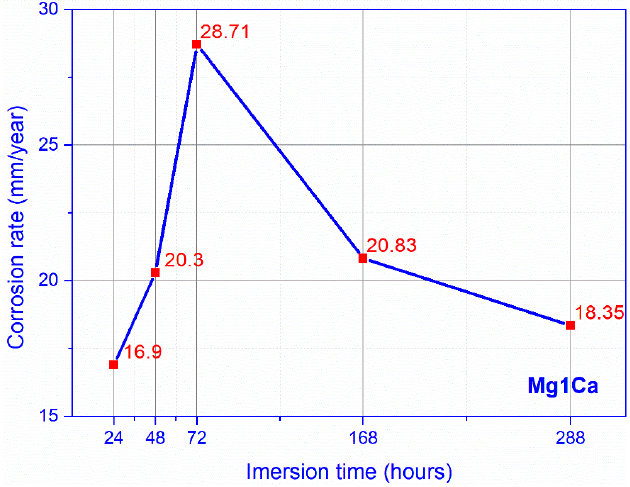
Figure 7. Corrosion rate SBF (mean values for three samples).